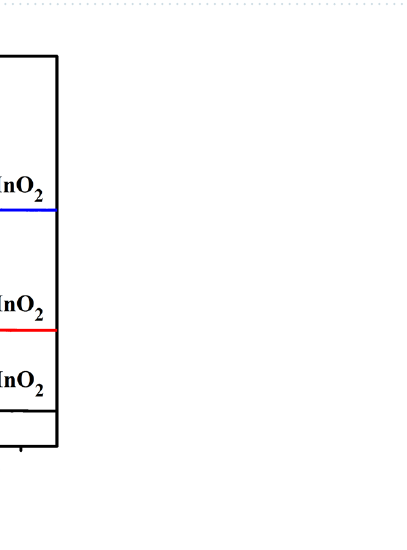
Figure 8. H 2 -TPR profiles of Ag/MnO 2